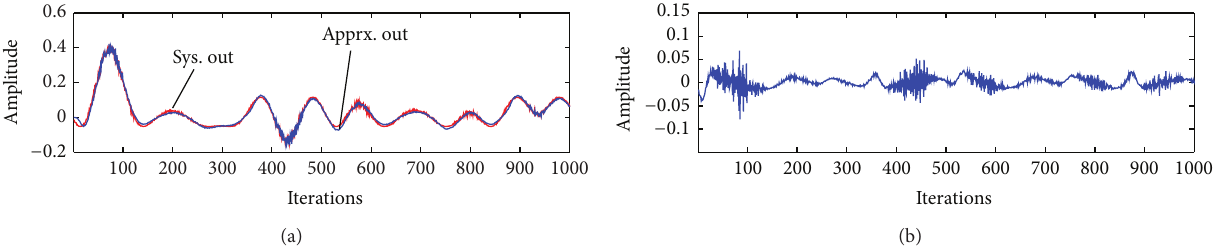
Figure 9: The simulation result with DR-LMS algorithm. (a) Process of identification. (b) Error of identification.